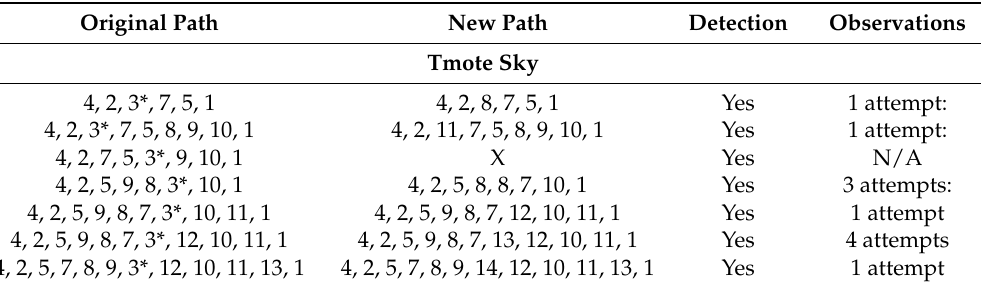
Table A2. Accuracy check for Single SF—ContikiMAC